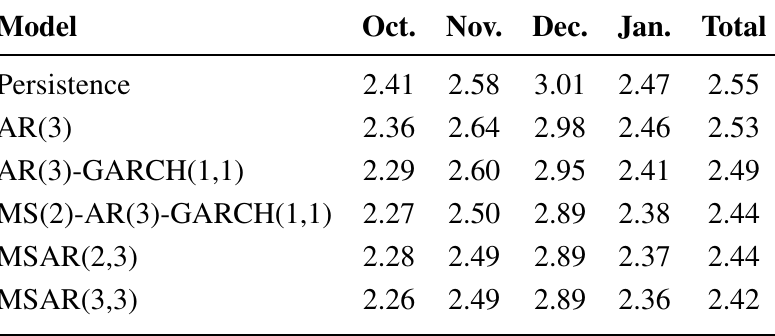
Table 4. NMAE score given in percentage of the nominal capacity of the Horns Rev 1 wind farm. Results are given for persistence, an AR model with 3 lags AR(3), a MSAR model with 2 regimes and 3 lags in the conditional mean equation MSAR(2,3), a MSAR model with 3 regimes and 3 lags in the conditional mean equation MSAR(3,3), an AR-GARCH model with 3 lags in the conditional mean equation and a GARCH(1,1) specification for the conditional variance, and finally for the MS-AR-GARCH model estimated in Section 5.